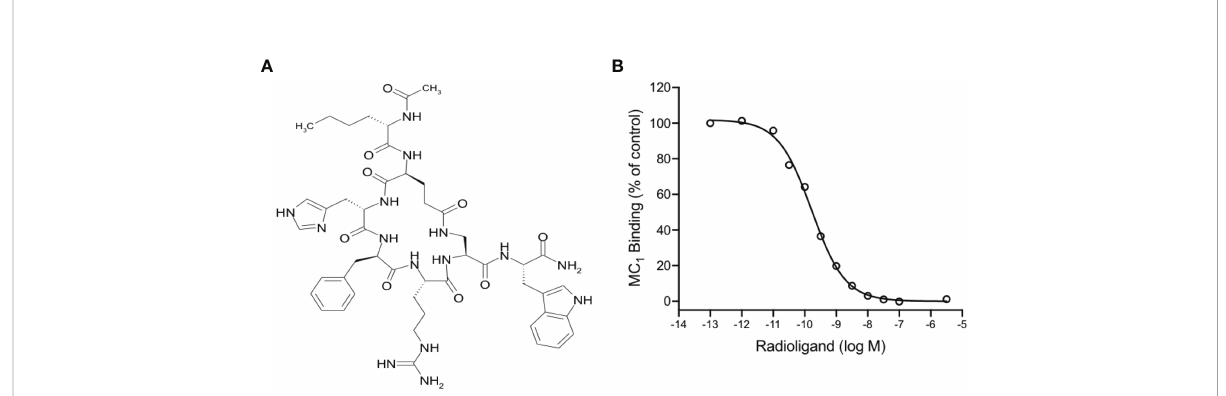
FIGURE 1 Chemical structure and binding of PL8177 to the mouse MC 1 receptor (A) Structure of PL8177, with amino acid sequence Ac-Nle 1 -cyclo(Glu 2 -L-His 3 - D-Phe 4 -Arg 5 -Dap 6 )-Trp 7 -NH 2 . (B) Binding af fi nity of PL8177 (0.1 pM – 10 µM) for mouse MC 1 receptor, expressed in B16-F1 cell line (Ki =75 pM). Data represent regression curve and mean values of n=3 independent